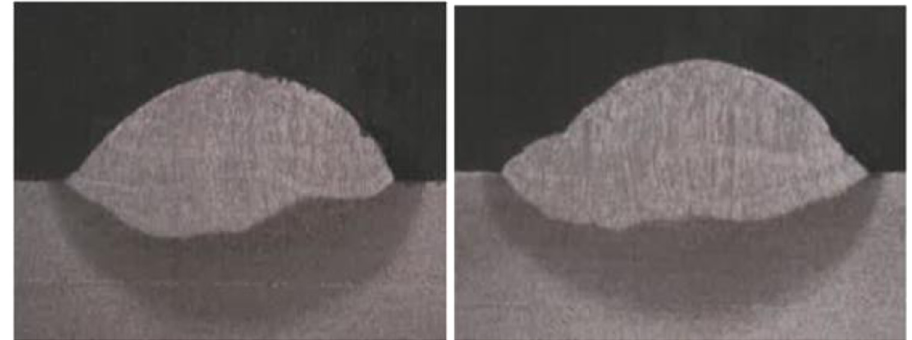
Figure 6: The welds ’ microstructures were produced by 9 L/min gas fl ow rate shown in the picture on the left and 18 L/min gas fl ow rate shown in the picture on the